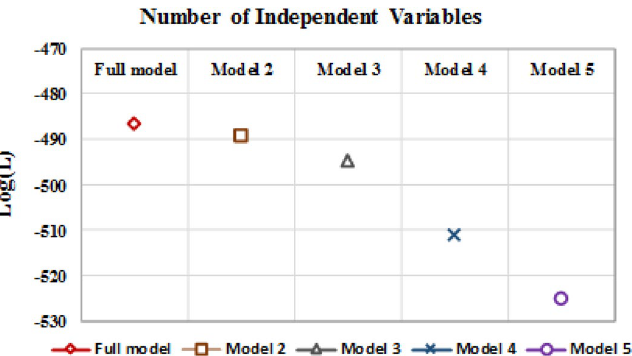
Figure 1. Log (L) Level for different models. (Models with variables: Model 1: Full Model (14 variables); Model 2: Stepwise (KCL, VEN, GEN, SMO, TBF, & WPL); Model 3: KCL, VEN, GEN and WPL; Model 4: VEN, GEN and WPL and Model 5: GEN and